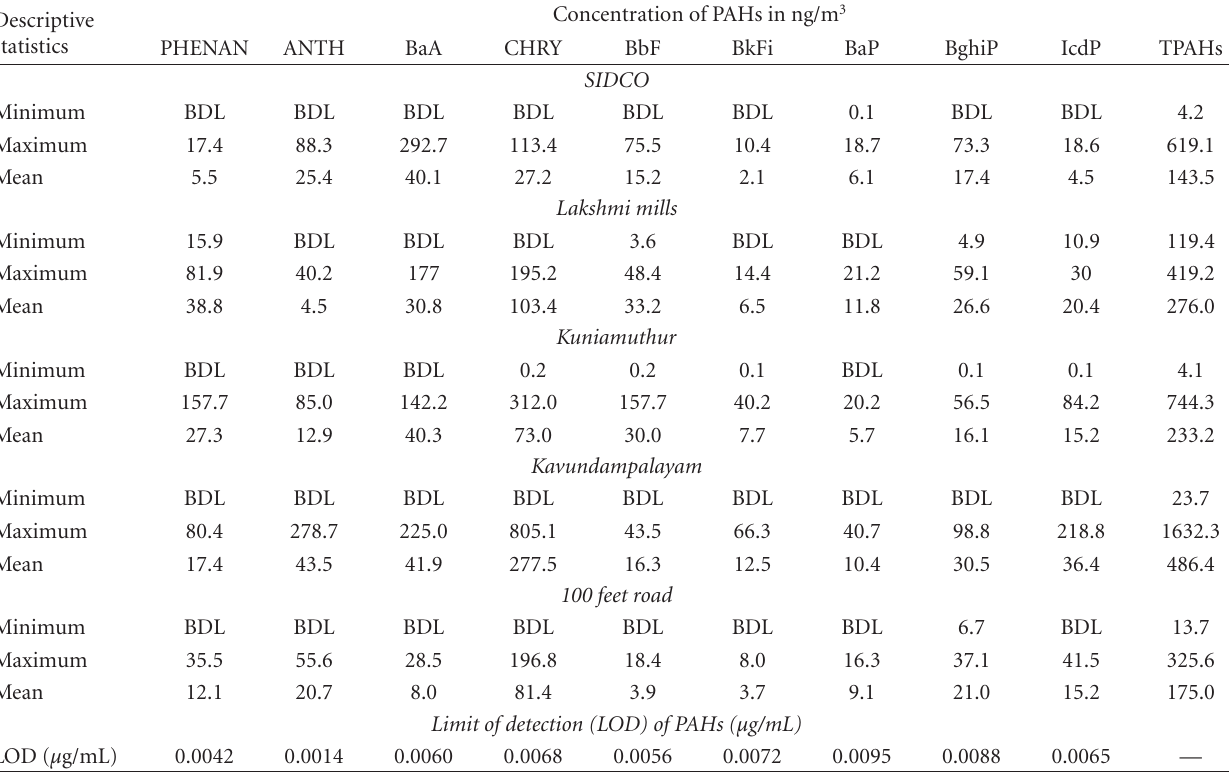
Table 2: Descriptive statistics for PAH concentrations in Coimbatore city.